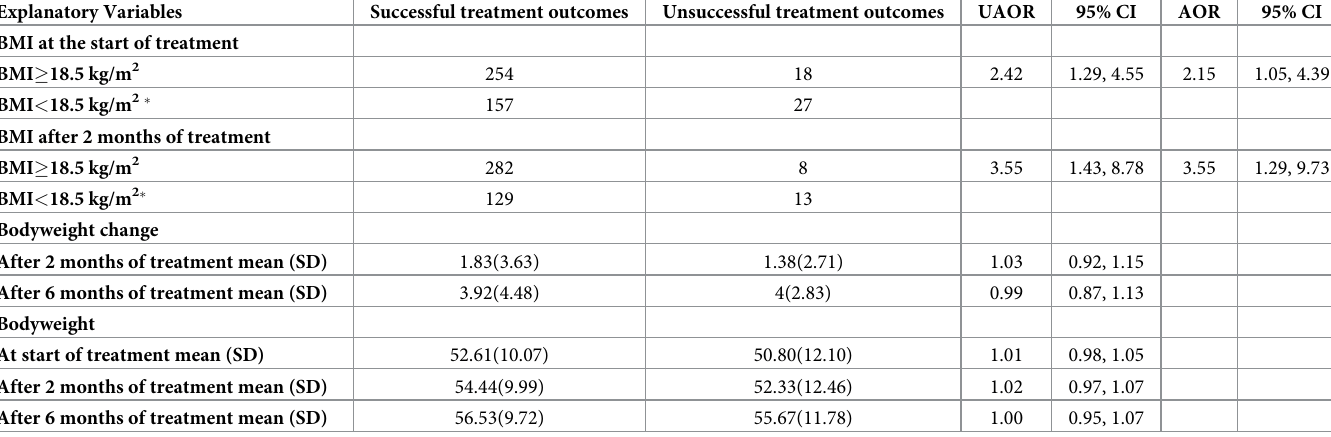
Table 3. Univariable and multivariable analysis of BMI and weight change association with treatment outcomes among adult TB patients in the public health center of Addis Ababa, Ethiopia, 2019.